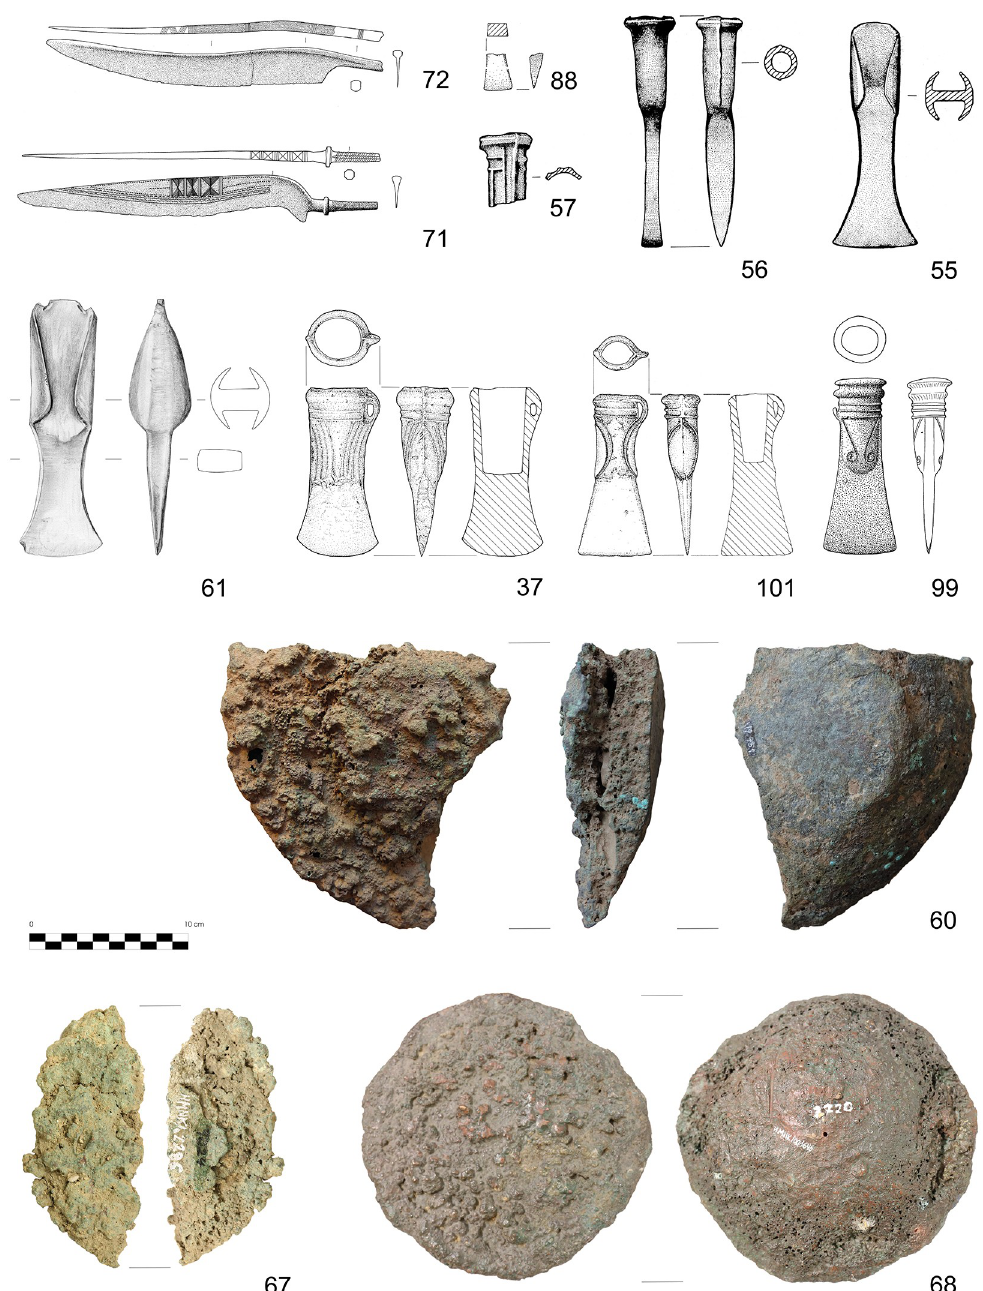
Fig 4. Selected copper and copper alloy finds from the Prigglitz-Gasteil surroundings. All sites are located in Lower Austria (see Fig 1). No 37: Prigglitz-Gasteil, Klausgraben; no 55, 56, 57, 60, 61: Gru¨nbach-Gela¨nde; no 67, 68: Neunkirchen-Klostera¨cker; no 71, 72: Pottschach; no 88: Reichenau-Kammerwandgrotte; no 99: Sieding-Murrer; no 101: Ternitz-Gfieder. Scale 1:4 (drawings no 37, 88, 101: Franz Drost; no 55–57: Anton Distelberger; no 61: Daniela Fehlmann; no 71, 72, 99: unknown artist, reproduced from the publications quoted in Table 1; photographs: no 60: Michael Konrad; no 67, 68: Peter Trebsche). The numbers correspond to those in the tables.